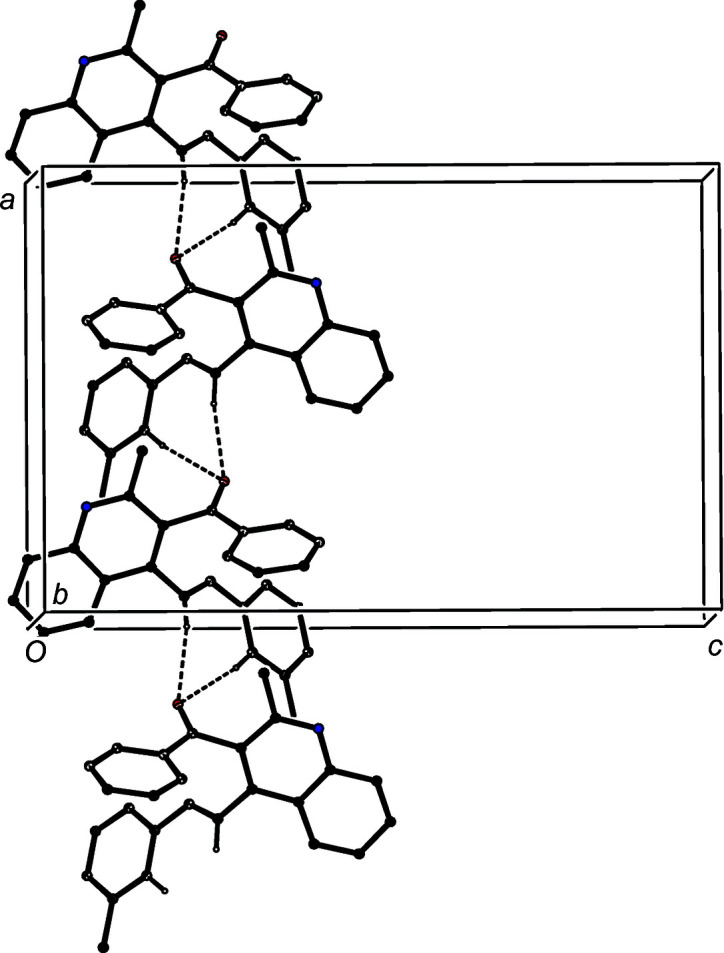
Part of the crystal structure of com­pound (VII), showing the formation of a C(6)C(9)[(7)] chain of rings running parallel to the [100] direction. Hydrogen bonds are drawn as dashed lines and, for the sake of clarity, H atoms which are not involved in the motif shown have been omitted.